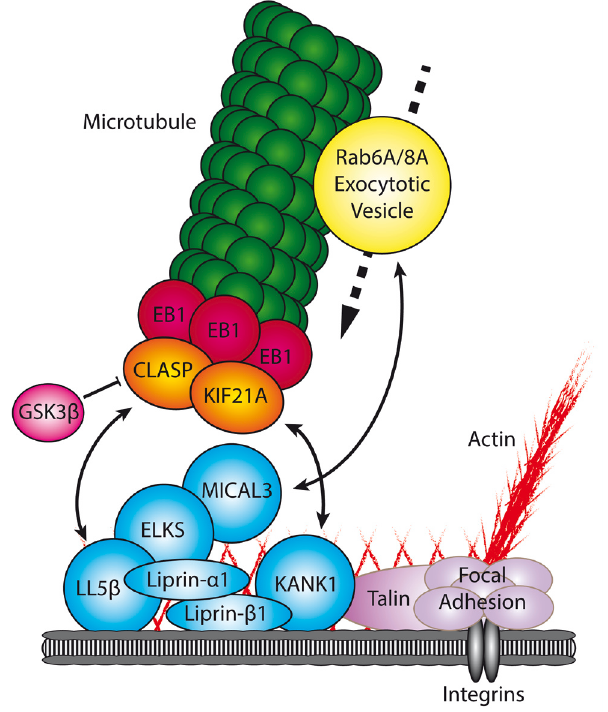
Figure 2. Schematic overview of the cortical microtubule stabilizing complex (CMSC) and associated proteins involved in microtubule capture and exocytosis. The CMSC (blue) captures microtubules through direct interactions with a specific subset of microtubule plus-end tracking proteins (+TIPs) (orange). CMSC components are found in the proximity of focal adhesions (purple), where they regulate microtubule-mediated focal adhesion turnover. Furthermore, the CMSC has been shown to directly interact with Rab6A/Rab8A-positive vesicles (yellow), thereby facilitating secretion. Double-headed arrow, protein interaction facilitating recruitment; bar-headed line, negative regulation; dotted arrow, movement in direction of